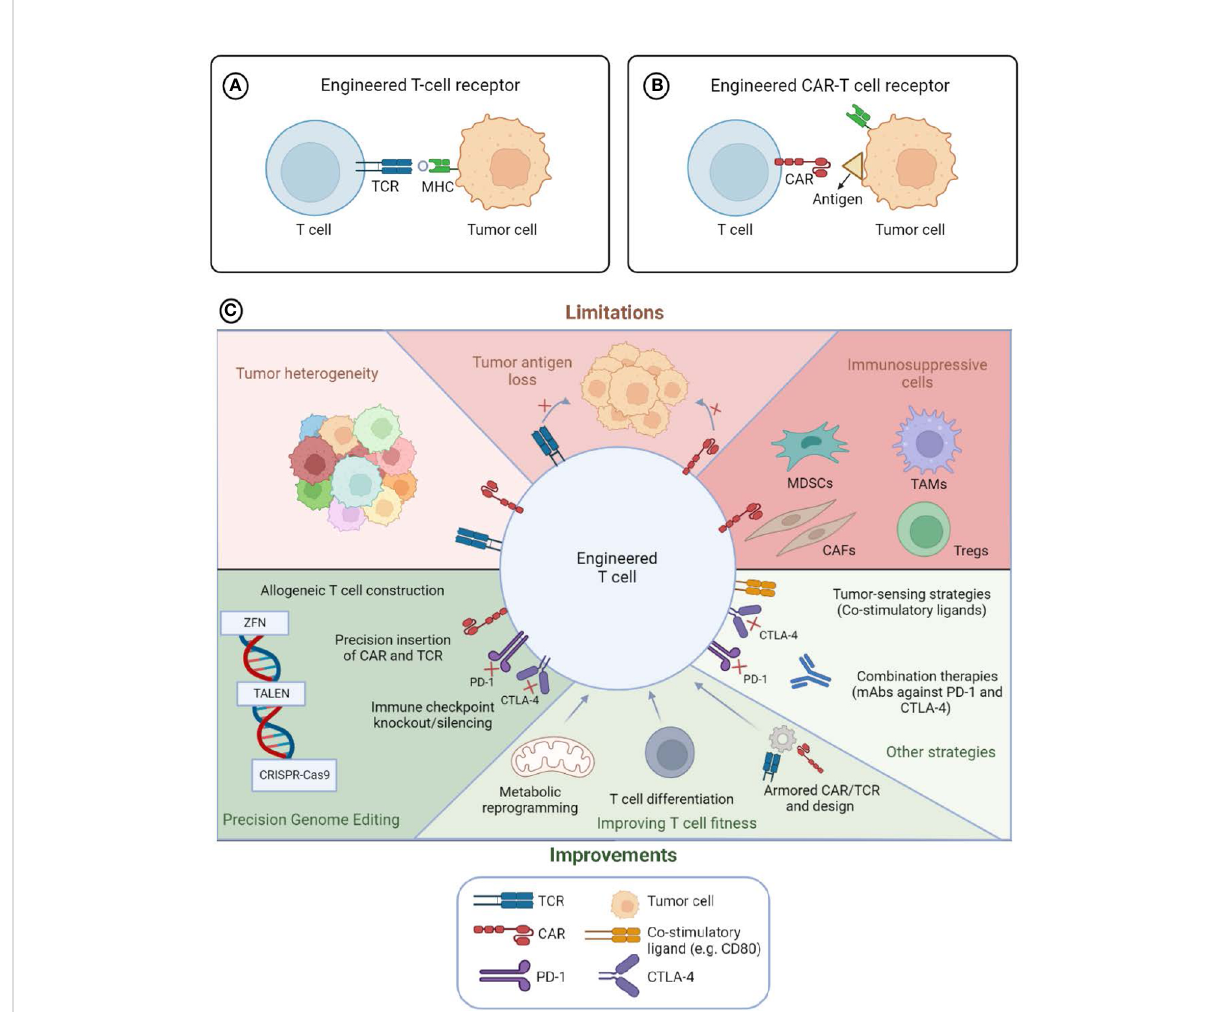
FIGURE 1 Engineered T cells to target tumor cells: limitations and advances. T lymphocytes engineered with T cell Receptor (TCR) (Panel A ) or Chimeric Antigen Receptor (CAR) (Panel B ) to redirect the immune cells toward tumor cells. The survival, proliferation and anti-tumor functions of engineered immune cells (Panel C ) can be in fl uenced by intrinsic factor of tumor cells, such as cell heterogeneity, antigen loss, or the immunosuppressive tumor microenvironment (TME) (Top part of Panel C entitled limitations). The administration of immune checkpoint blockade agents or co-stimulatory molecules in combination with engineered lymphocytes can modify the tumor milieu and implement the anti-tumor functions of the cellular products. Moreover, the modi fi cation of the fi tness of the lymphocytes through actions that can change either the metabolomic pro fi le, the differentiation status or the cytokine or immune checkpoint expression can lead to potentiate the functions of the immune cells (bottom part of Panel C entitled improvements). Precision genome editing (through the usage of either Zinc fi nger nuclease, ZFN, Transcription activator-like effector nuclease, TALEN or clustered regularly interspaced short palindromic repeats (CRISPR)/ CRISPR associated protein 9 (CAS9)) can increase the expression of the antigen-speci fi c receptors, modify the fi tness of the immune cells and/ or implement the safety of the cell-therapy product. MDSCs, Myeloid-derived suppressor cells; TAMs, Tumor-associated macrophages; CAFs, Cancer-associated fi broblasts; Tregs, regulatory T cells. Created with